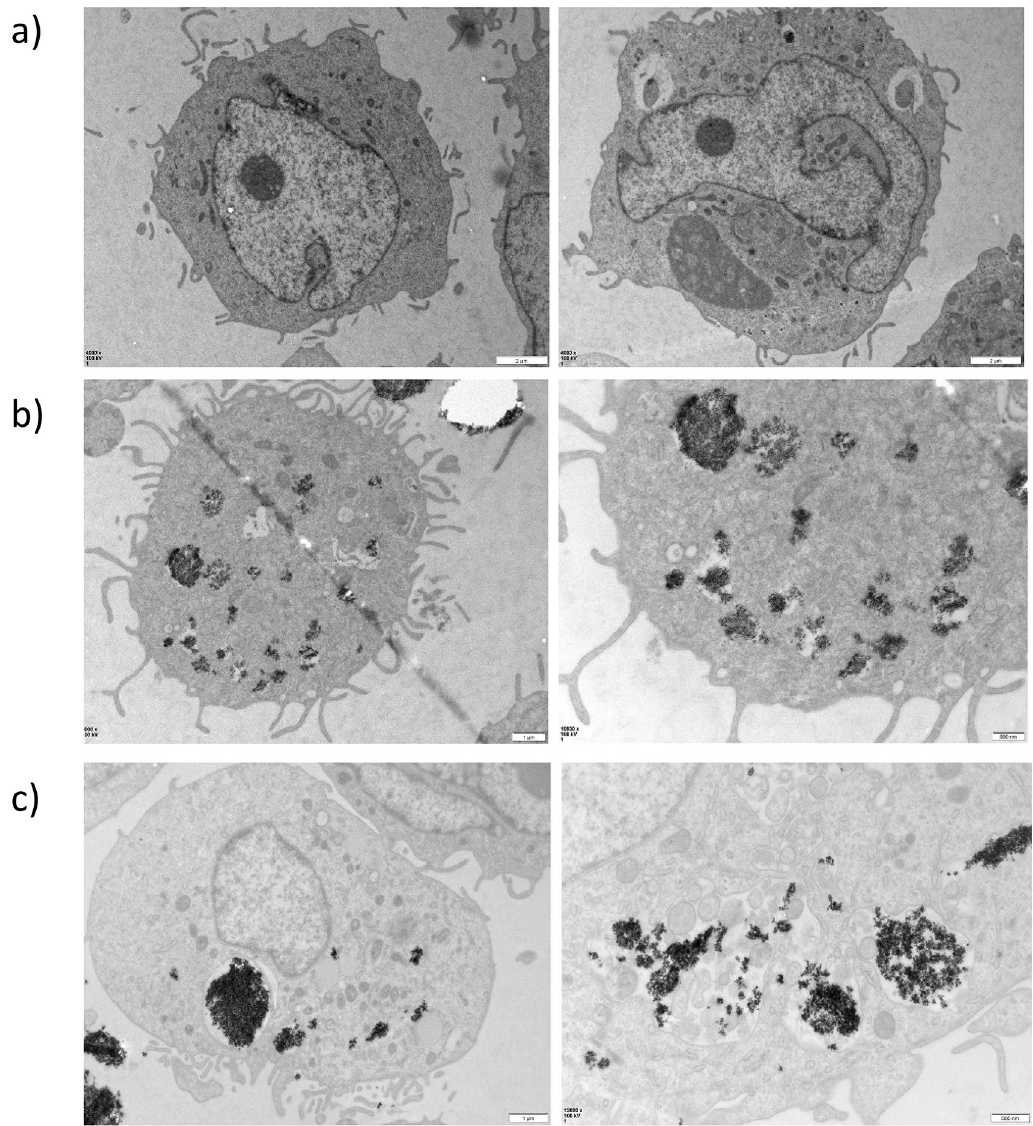
Figure 1. TEM images of THP-1 macrophages following metal oxide ceramic nanopowder treatment. THP-1 cells were activated to M1 macrophage phenotype using PMA and then either left untreated and given only fresh complete RMPI-1640 media or treated with ceramics for 24 h before being prepared and imaged using transmission electron microscopy. ( a ) Untreated THP-1 cells did not receive any dose of ceramic oxide nanopowders. These macrophages cells can be seen to have a characteristic large nucleus and formed pseudopodia, both of which are representative of an activated macrophage cell. ( b ) THP-1 cells treated with Al 2 O 3 (50 μm 3 particles per cell) for 24 h prior to TEM imaging. Dark areas of clumped staining show ceramic phagocystosed by the macrophage and held within distinct vacuole-like structures. ( c ) THP-1 macrophages treated with ZrO 2 (50 μm 3 particles per cell). Dense areas of dark staining show large distinctive clumps of ceramic which has been phagocytosed by the cell. Round vacuole-like structures surround the ceramic maintaining it within the Trypan Blue and IL-1β secretion was analysed using ELISA. There were statistically significant decreases in cell viability following treatment with LPS and ceramics (P = 0.0001 for Al 2 O 3 and P < 0.0001 for ZrO 2 ). However, no significant increase in IL-1β protein secretion was found in the cells which received Al 2 O 3 after the LPS pre-treatment (P = 0.4912). The ZrO 2 -treated cells, on the other hand, experienced a significant increase in the secretion of IL-1β (P = 0.0045) (Fig. 6). TLR4 blockade of THP-1 macrophages was used in order to determine the role of TLR4-mediated immu- nomodulation in the context of inflammasome activation. THP-1 macrophages were pre-treated with CLI-095 for 6 h and then subsequently treated with 10 ng/mL LPS as a positive control or 50 µm 3 per cell Al 2 O 3 or ZrO 2 , and untreated cells were used as a negative control. Protein was then extracted using RIPA buffer and total protein concentration determined before separation via gel electrophoresis and transfer of proteins to a PVDF